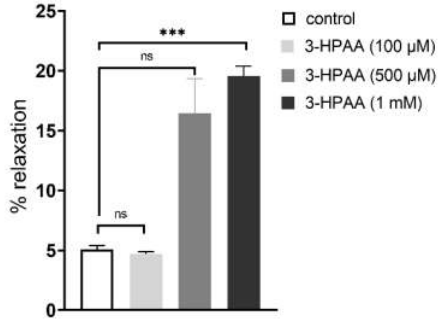
Figure 5. Confirmation of the vasodilatory effects of 3-hydroxyphenylacetic acid (3-HPAA) in por- cine coronary arterial rings ( n = 6). Data are expressed as % from the maximal relaxation induced by sodium nitroprusside (100 µM). Significant change: *** p < 0.001 vs. control, ns—not significant.